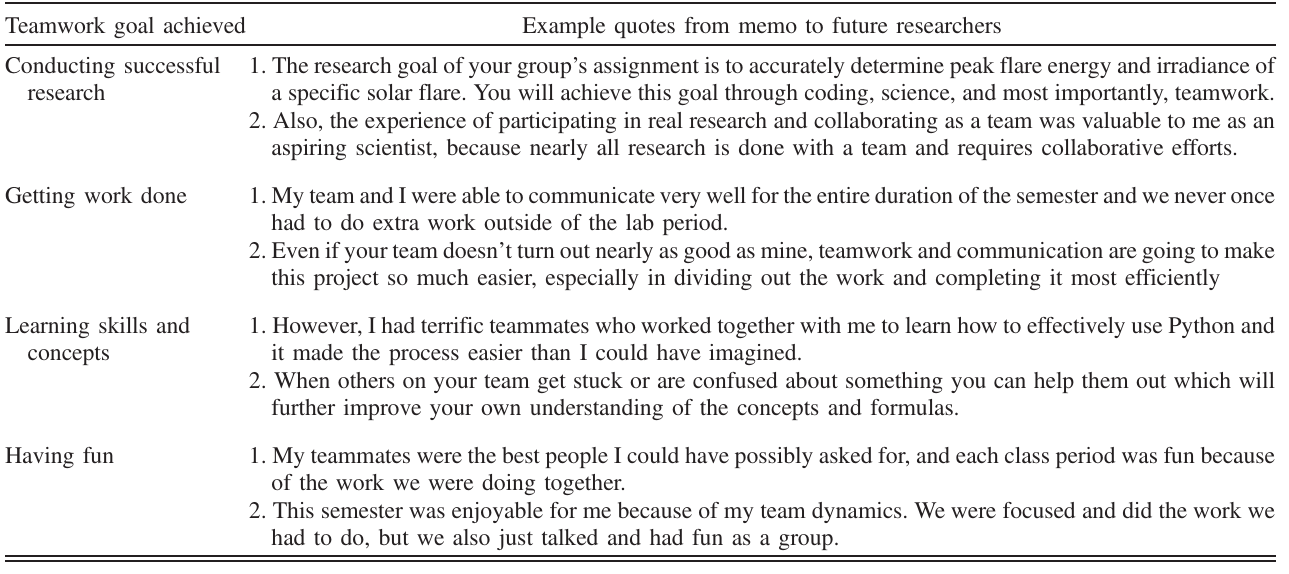
TABLE VIII. Example quotes highlighting various teamwork goals that students expressed they achieved in the memos to future